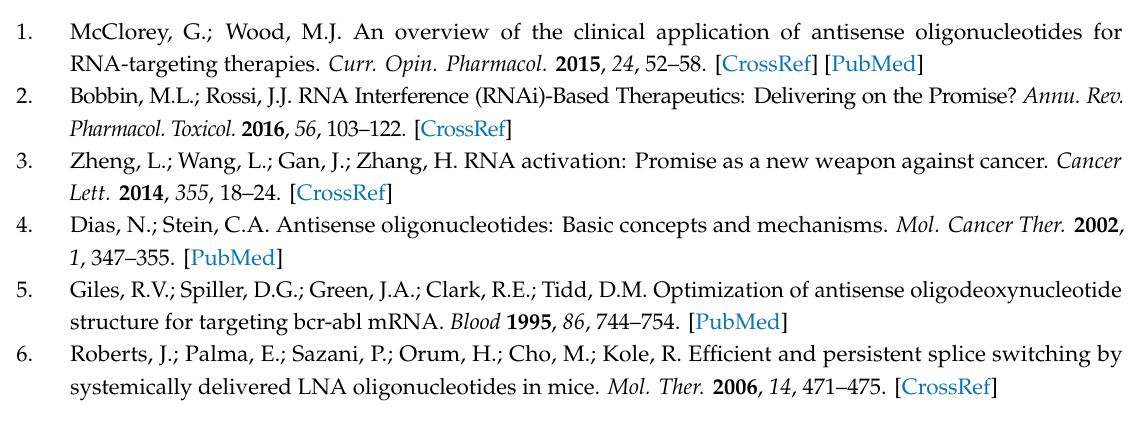
Figure S8: PAGE analysis of a CTGF-repressible conditional hybrid pair, Figure S9: Time course FRET experiments of a multi-input conditional hybrid pair, Figure S10: E ff ect of trigger titration on dsRNA release from a multi-input conditional hybrid pair, Figure S11: PAGE analysis of a 3-piece trigger-inducible RNA / DNA hybrid, Figure S12: PAGE analysis of a 3-piece trigger-repressible RNA / DNA hybrid, Table S1: Statistical significance of dsRNA release from a single adjacent-targeting hybrid pair at various timepoints, Table S2: Statistical significance of dsRNA release between various adjacent-targeting hybrid pairs at a single time point, Table S3: Statistical significance of dsRNA release among various trigger-inducible sH ˆCTGF hybrids pairs at a single time point, Table S4: Statistical significance of dsRNA released for a given sH ˆCTGF when paired with aH ˆCTGF-cgnt.12 versus aH ˆCTGF-cgnt.16 , Table S5: Statistical significance of dsRNA release from a single CTGF trigger-inducible hybrid pair at various timepoints, Table S6: Statistical significance of dsRNA released for the KRAS-repressible hybrid